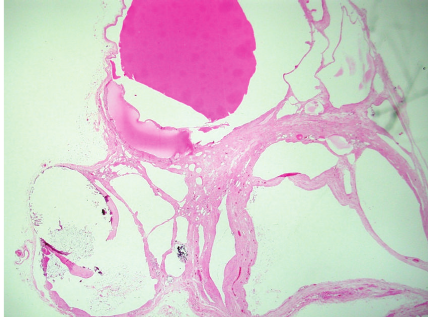
Figure 3: low power view of the adrenal cyst composed of multi- locular spaces filled with eosinophilic material. Note the presence of calcification at the lower left side of the photo (H&E stained slide).